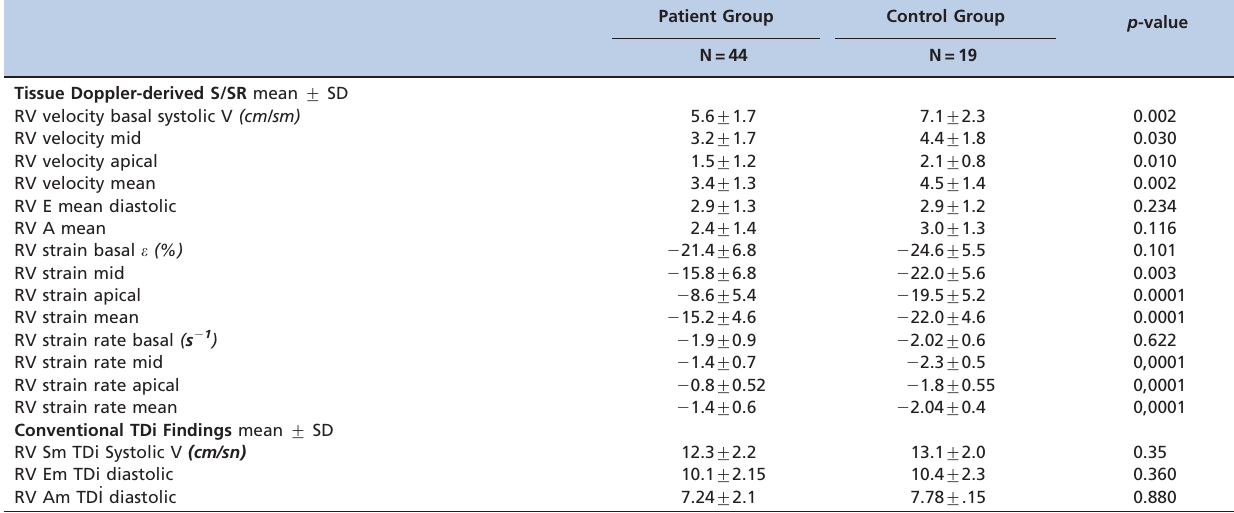
Table 2 - Tissue Doppler and Strain/Strain Rate Findings.